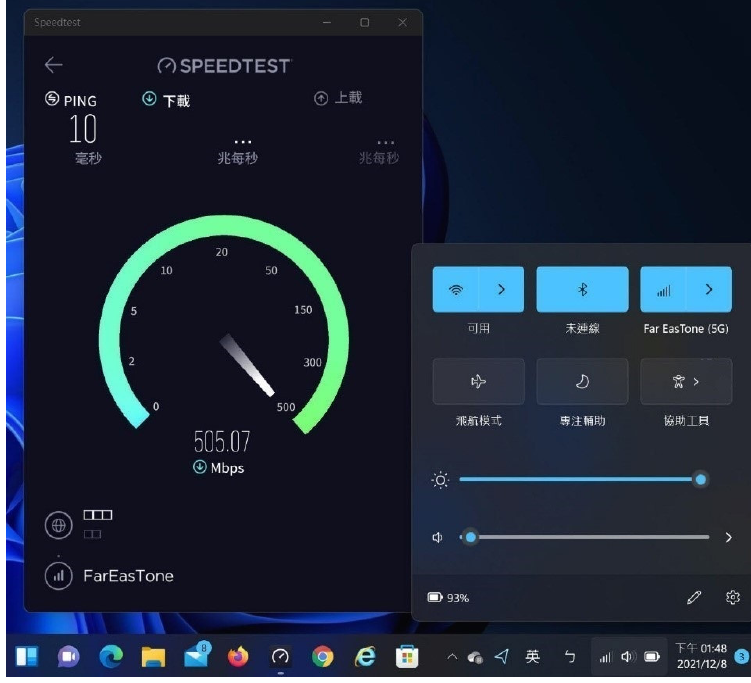
Figure 24. 5G test speed